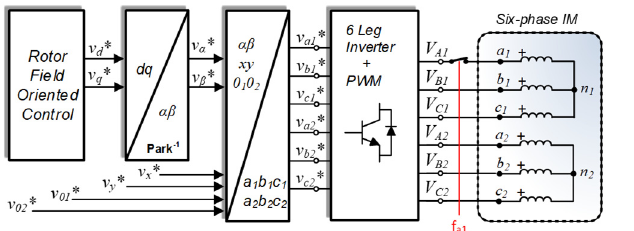
Figure 4. Six-phase induction motor drive (two isolated neutral) with RFOC and one reconfigurable OPF on phase a 1 . The signal f a1 is to emulate the OPF.